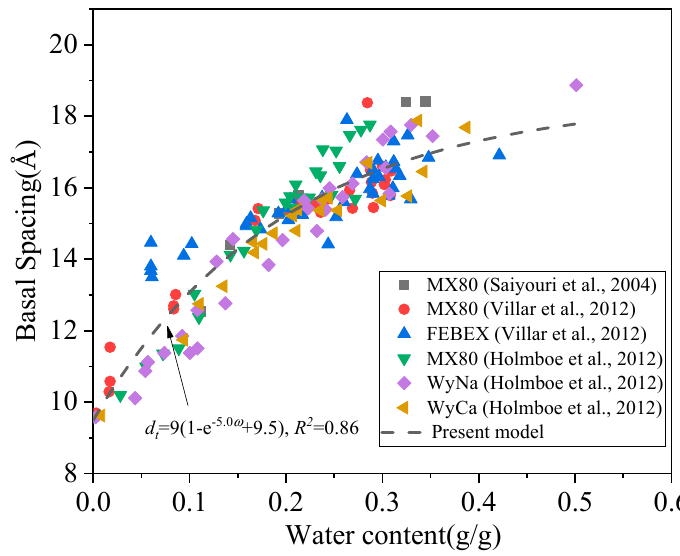
where b is a constant correlating with water absorption rate, which is − 5.0 obtained by the experimental data (see Figure 3), d TOT and d t are the thickness of a single TOT layer and the basal spacing, respectively, e is natural logarithm.